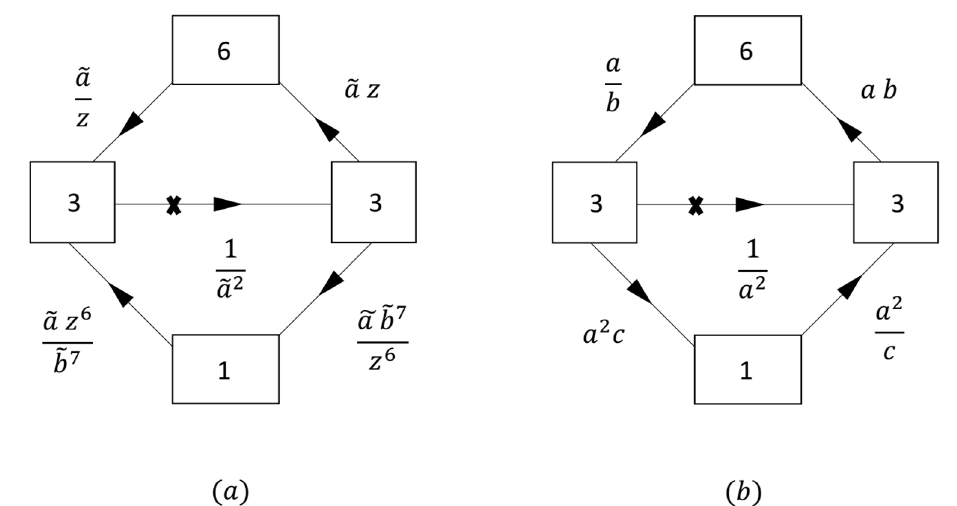
Figure 13 . The SU-SU tubes for the case of N = 2 with (a) the (7 , 0) split and (b) the (6 , 1) split. Charges under the global symmetries are denoted using fugacities. In (a) we have also split the 7 chirals on the two sides to 6+1 , and correspondingly only the SU(6) × U(1) z subgroup of the SU(7) global symmetry is manifest in the